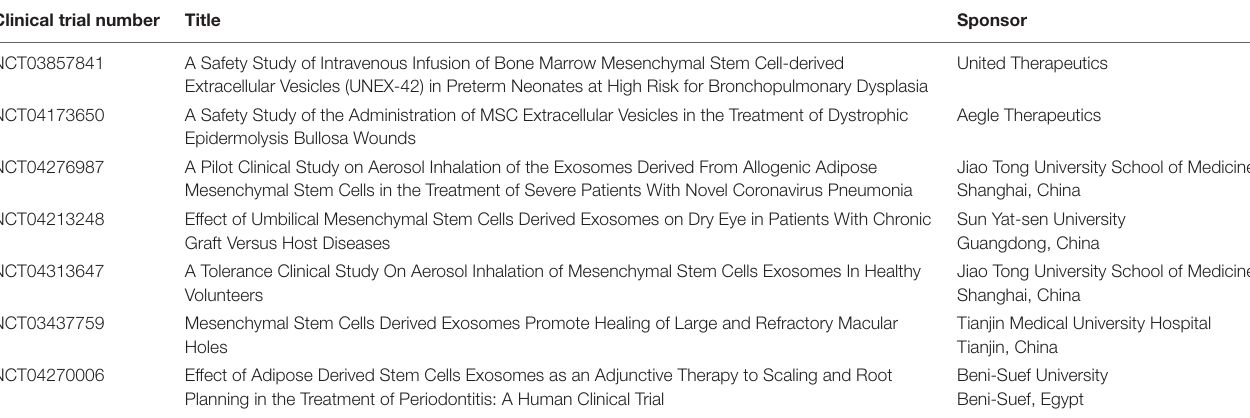
TABLE 1 | Clinical trials infusing MSC-derived exosomes.